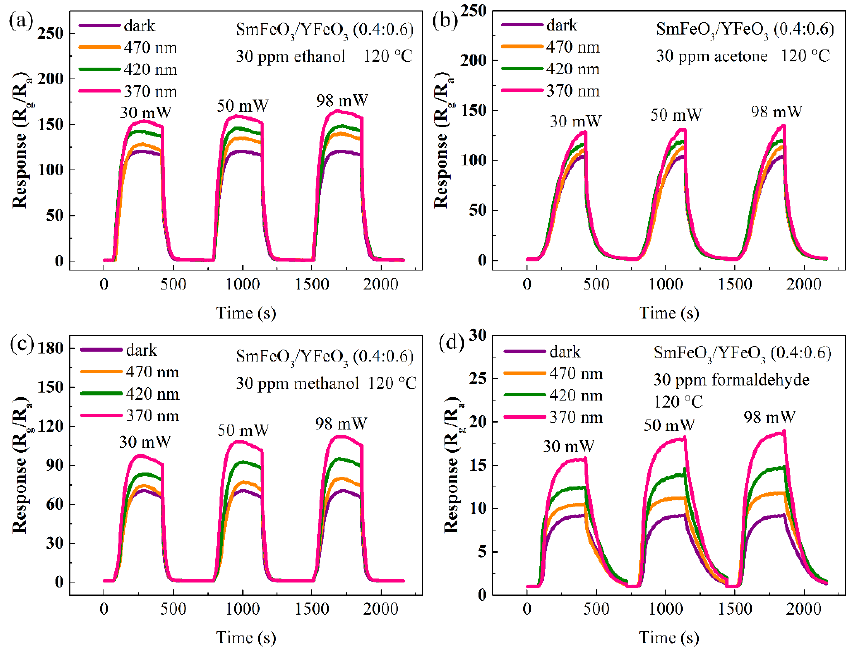
Figure 12. Dynamic-response curves under different optical powers of the SmFeO 3 /YFeO 3 (0.4:0.6) sensor for VOC gases under multi-wavelength light illumination: ( a ) ethanol, ( b ) acetone, ( c ) methanol, and ( d ) formaldehyde.